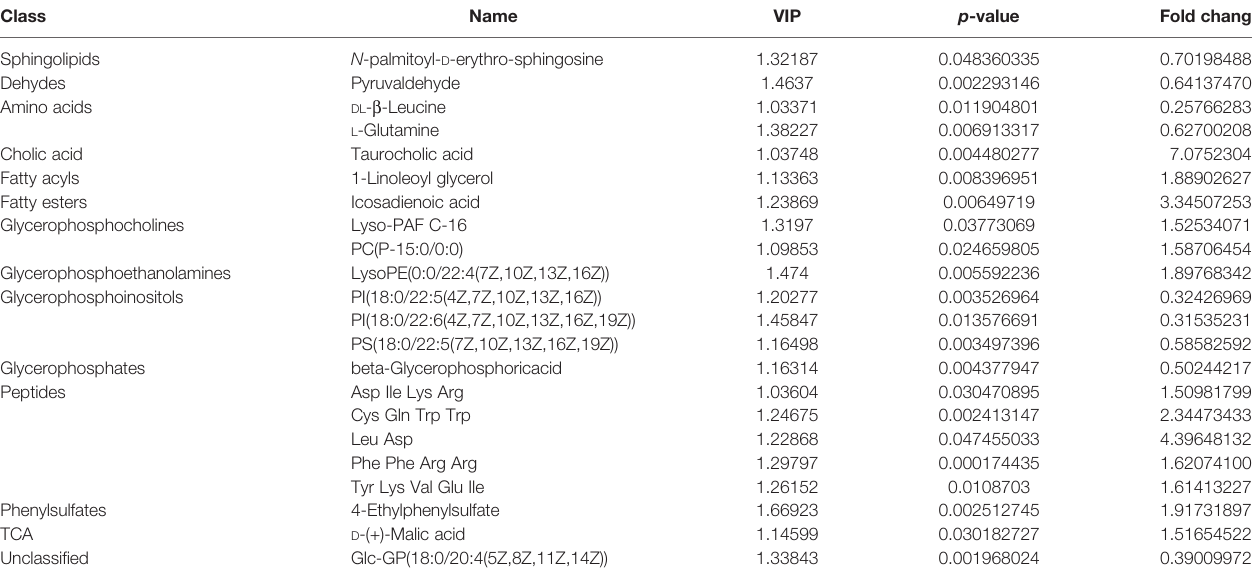
TABLE 1 | Dysregulated metabolites between the DHEA+Sham and DHEA+BAT groups.